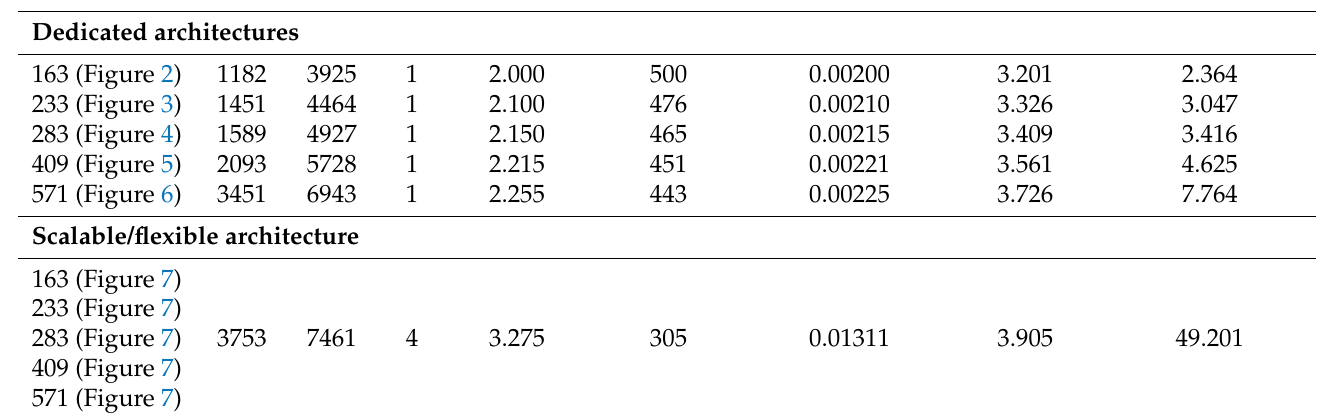
Table 1. Implementation results of our proposed dedicated and scalable least-significant